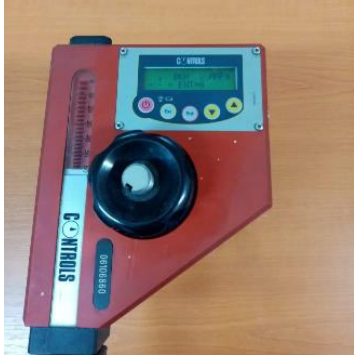
Figure 9. Apparatus for testing adhesion to the support layer. As a principle of operation, this device is a dynamometer equipped with load cell and digital display. After proper bonding of the traction pills in the center of the surface of the test specimens (at the age of 28 days), the tensile force was applied manually and perpendicularly to the tested surfaces (without shocks and with uniform speed). The value obtained can be read on the screen.